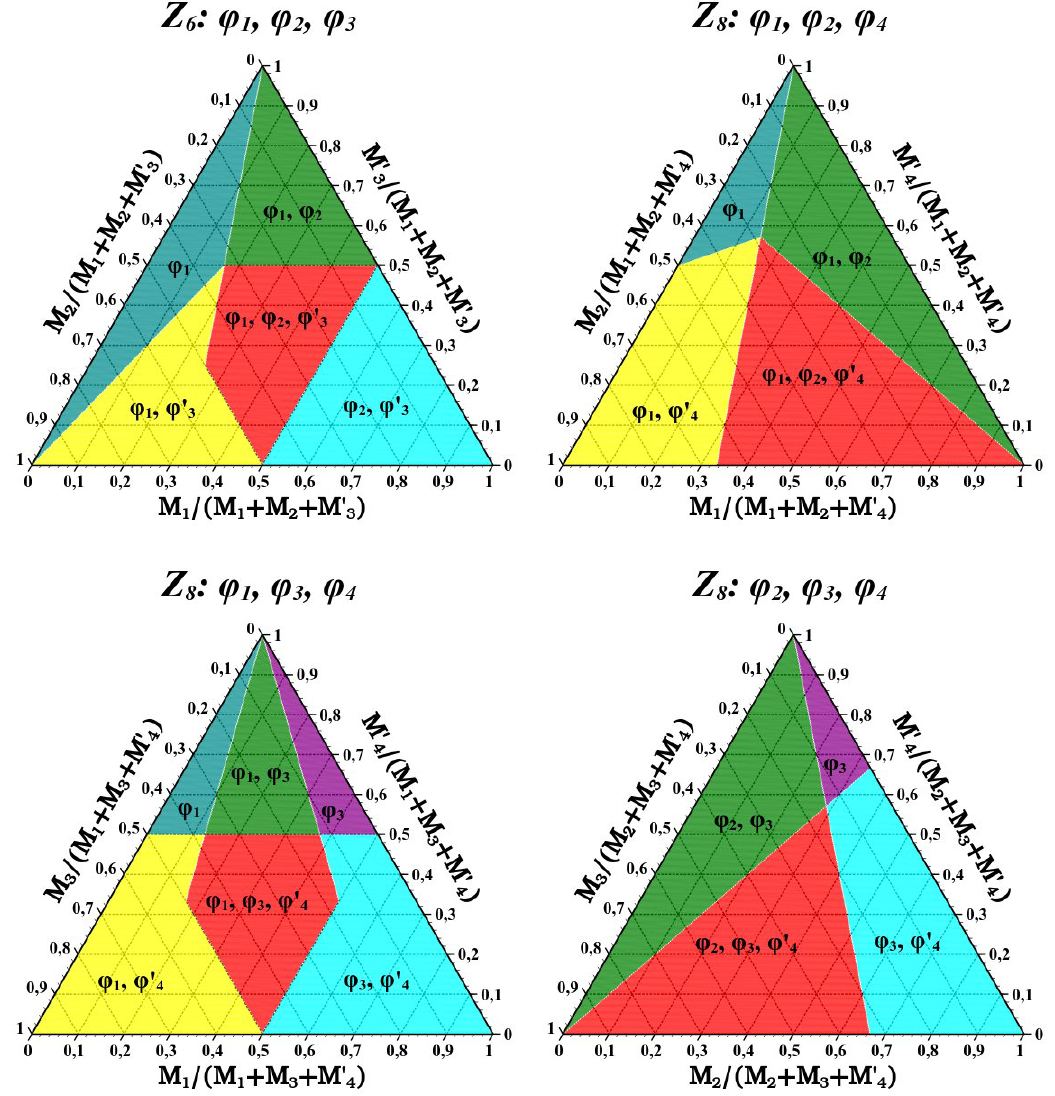
Figure 7 . Stability regions for a Z 6 with (cid:12)elds (cid:30) 1 ; (cid:30) 2 ; (cid:30) 3 (top left panel), and for a Z 8 with di(cid:11)erent sets of (cid:12)elds: (cid:30) 1 ; (cid:30) 2 ; (cid:30) 4 (top right panel), (cid:30) 1 ; (cid:30) 3 ; (cid:30) 4 (bottom left panel) and (cid:30) 2 ; (cid:30) 3 ; (cid:30) 4 (bottom right panel). For the Z 6 ( Z 8 ) symmetry the (cid:12)eld (cid:30) 3 ( (cid:30) 4 ) denotes the real part of the corresponding